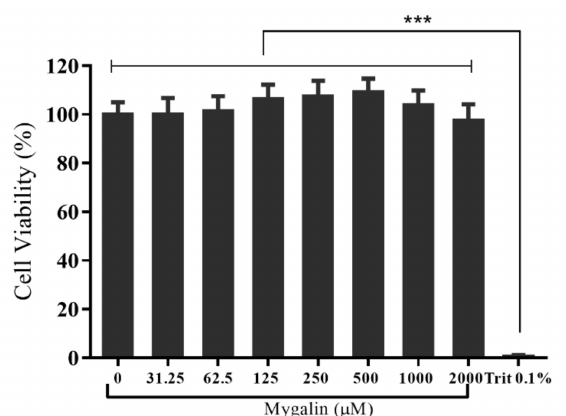
Figure 3. E ff ect of mygalin on cell viability. The e ff ects of mygalin (0–2000 µ M) were compared with the e ff ects of 0.1% Triton (nonviable cells). The results represent the mean ± SEM from three independent experiments (*** p < 0.001).